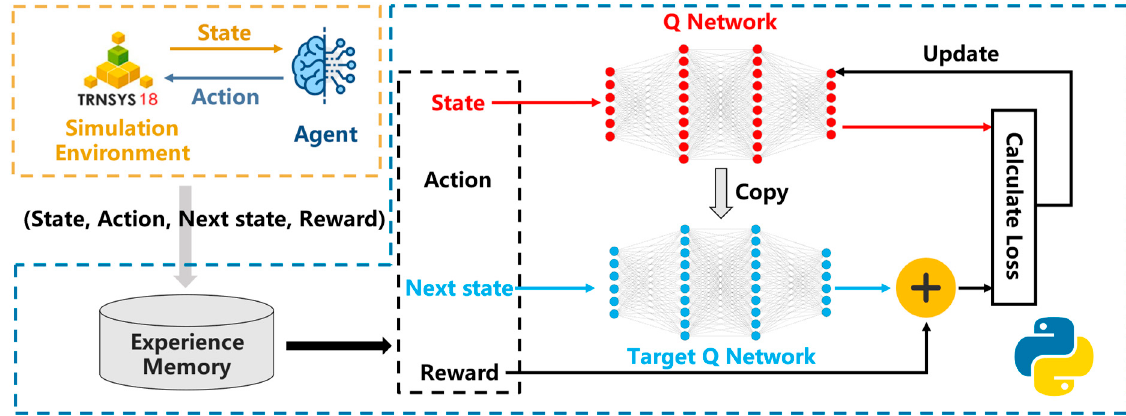
Figure 4. Overall architecture of the TRNSYS–Python co-simulation platform.